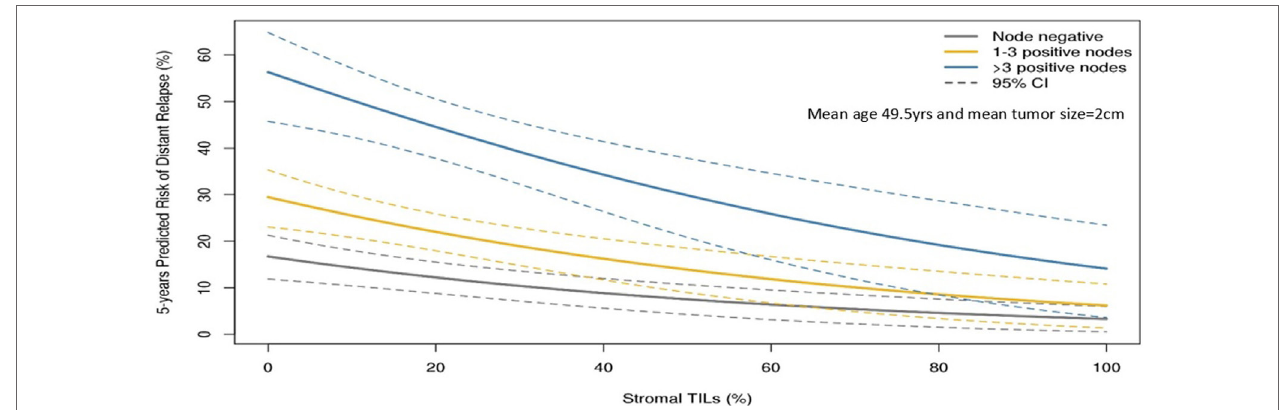
FiGURe 1 | Model to predict risk of distant recurrence at 5 years (%) by tumor-infiltrating lymphocytes (TILs) and nodal status by tumor size and age. The predicted rate of distant recurrence on the y axis as a continuous function of the level of stromal TILs in the primary tumor on the x axis is presented according to nodal status after adjuvant chemotherapy. This prognostic algorithm is for TNBC and assumes a mean age of 49.5 years and mean tumor size of 2 cm. Loi et al., San Antonio Breast Cancer Symposium 2015